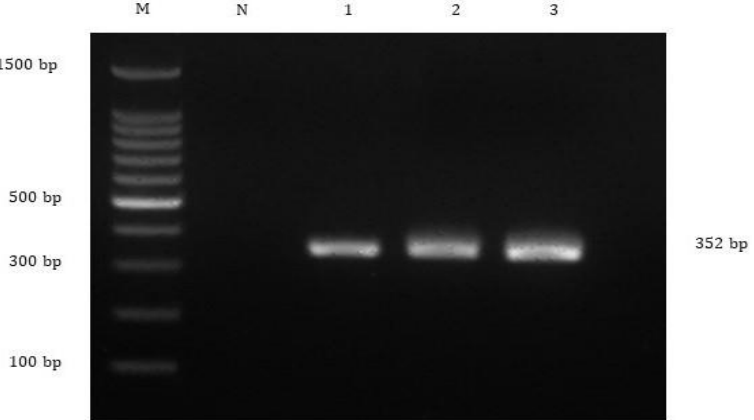
Figure 4. Agarose gel electrophoresis showing detection of 352 bp of Streptococcus agalactiae targeting cpsG gene from the affected fish. Lane M = 1 kb DNA marker; Lane N = negative control; Lane 1 to 3 = All S. agalactiae -positive samples yielded 352 bp amplicons.